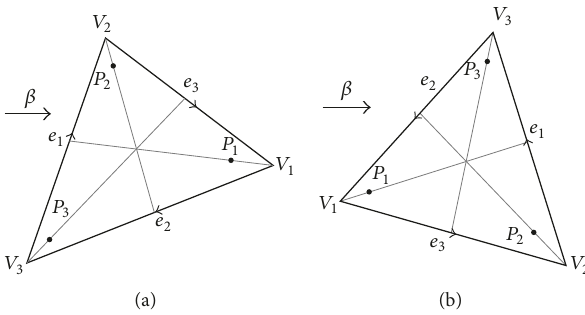
Figure 4: Configuration of internal nodes for reaction-dominated regime: one inflow edge (a) and two inflow edges (b) (figure reproduced from [15] [under the Creative Commons Attribution License/public domain]).